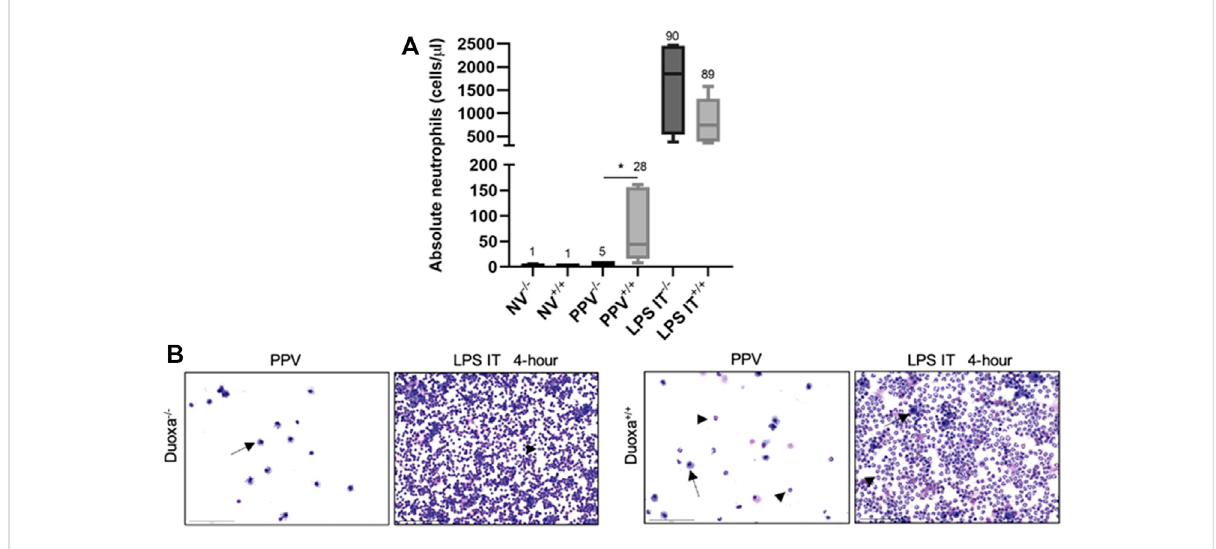
FIGURE 1 Duox is differentially required for neutrophil migration into the airway based on stimulus. (A) Neutrophil counts in lung lavage from Duoxa knockout mice ( − / − ) and wild-type mice (+/+) that were unventilated (NV), subjected to injurious positive pressure ventilation (PPV), or instilled intratracheally with lipopolysaccharide (LPS). Numbers above each bar represents percent neutrophils compared to total cells counted. *, p = .004 . (B) Bronchoalveolar lavage cytology after positive pressure ventilation (PPV) or LPS instillation in Duoxa knockout ( − / − ) and wild-type (+/+) mice. Arrows highlight macrophages, arrowheads highlight neutrophils. Images were obtained at ×40 magni fi